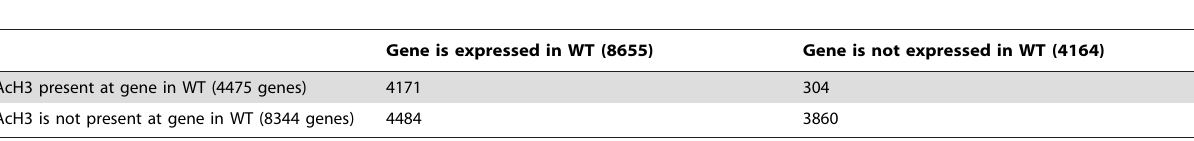
Table 3. Histone H3 acetylation and gene expression in WT striata.